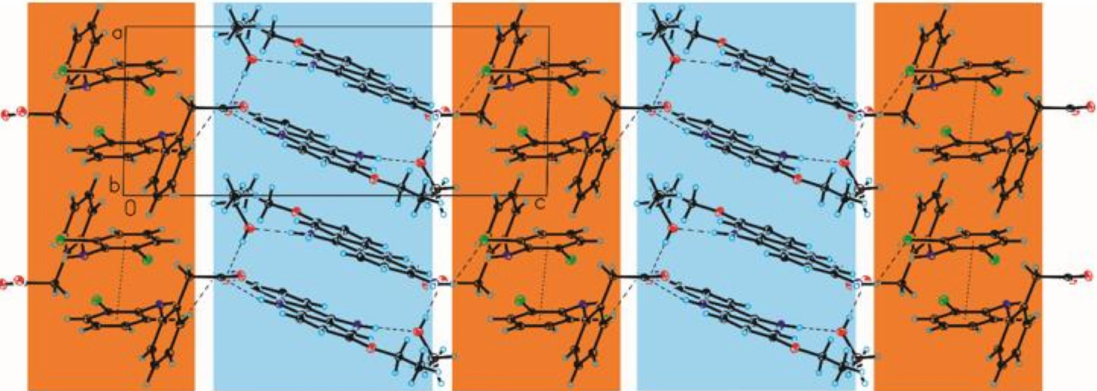
Figure 6. Crystal packing of compound 2 viewed along the b -axis (hydrogen bonds are represented by dashed lines, whereas π – π interactions are represented by dotted